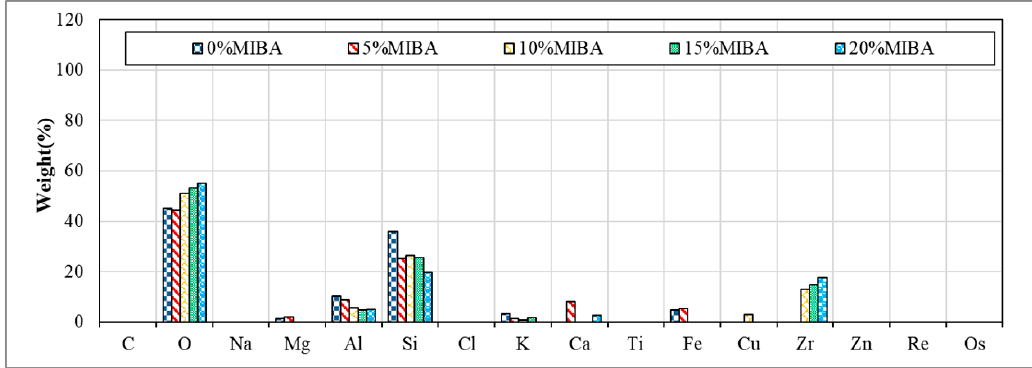
Table 4. XRD of 10%, 20% SSA, and 0% to 20% MIBA at various kiln temperatures. SSA% Temperature